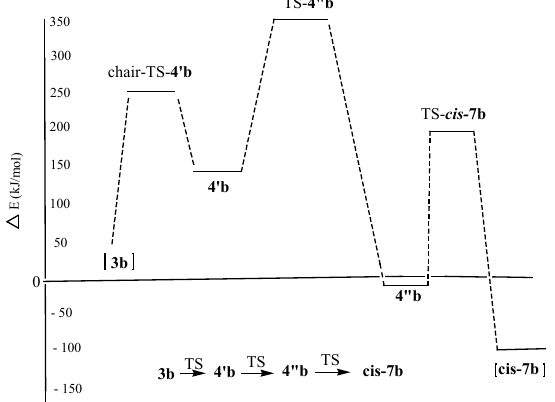
Figure 1. Energy diagram of the formation of compound 7b .